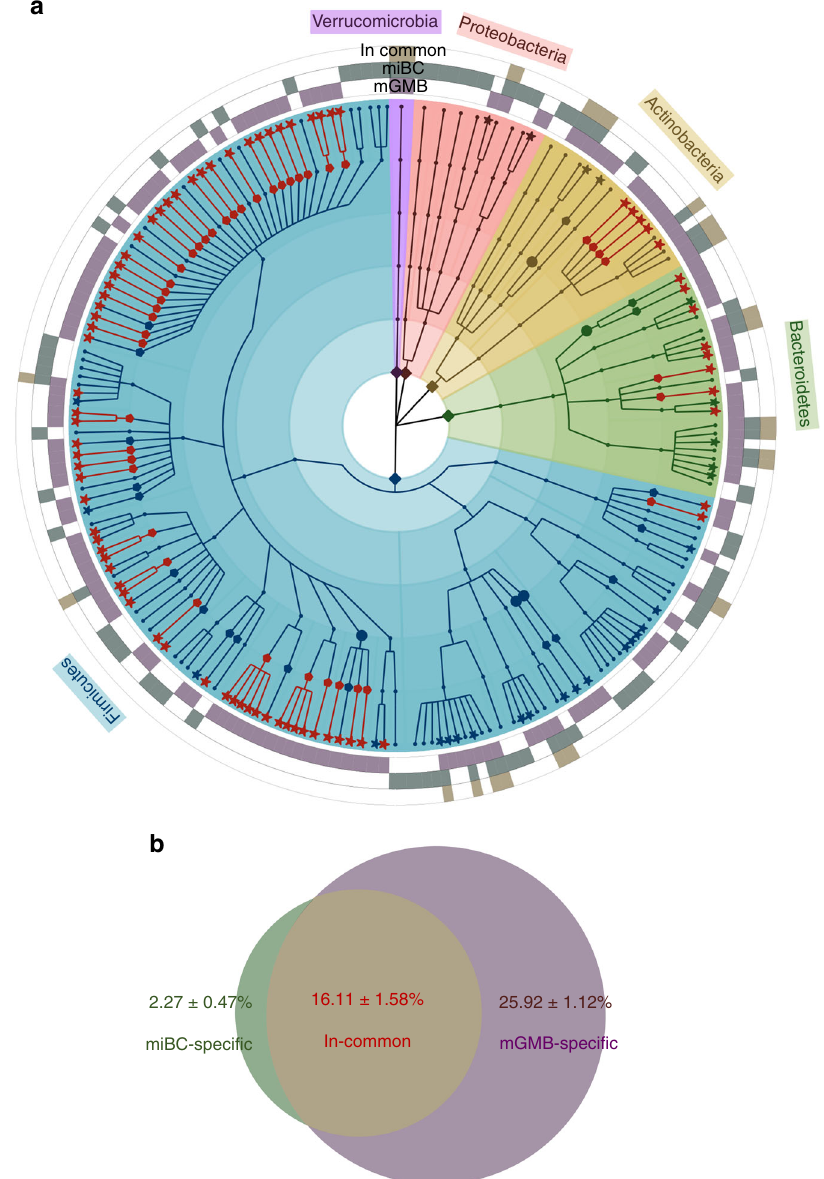
Fig. 1 The taxonomic diversity and contribution of mGMB to the mouse intestinal bacterial collection. a The cladogram displays the taxonomic diversity of bacteria in the mGMB and miBC. The mGMB and miBC together have 180 bacterial species from 110 genera, 33 families, and 5 phyla. The background is color-coded according to phyla. All 104 species unique to the mGMB are marked with star symbols, and the 77 new species are indicated with red stars. All 62 genera uniquely represented by mGMB members are indicated with pentagon symbols, and the 43 newly identi fi ed genera are indicated with red pentagons. The fi ve families unique to the mGMB are symbolized by solid circles. The 126 species in the mGMB are indicated by the fi rst-level purple external ring (labeled as mGMB in panel a ). The 76 species in the miBC are indicated by the second-level green external ring (labeled as miBC in panel a ). The 22 species in both the mGMB and miBC are indicated by the third-level yellow external ring (labeled as in common in panel a ). b The Venn diagram displays the read coverage of mGMB and miBC to the 16S rRNA gene amplicon dataset of mouse samples ( n = 93) from miBC work 12 at species level (sequence identity > 97%). The miBC-speci fi c (2.27 ± 0.47%): the proportion of reads uniquely covered by the miBC; The mGMB-speci fi c (25.92 ± 1.12%): the proportion of reads uniquely covered by the mGMB; The In-common (16.11 ± 1.58%): the proportion of reads shared by both collections. The coverage rate is present as mean ± SEM. Source data are provided as a Source Data fi